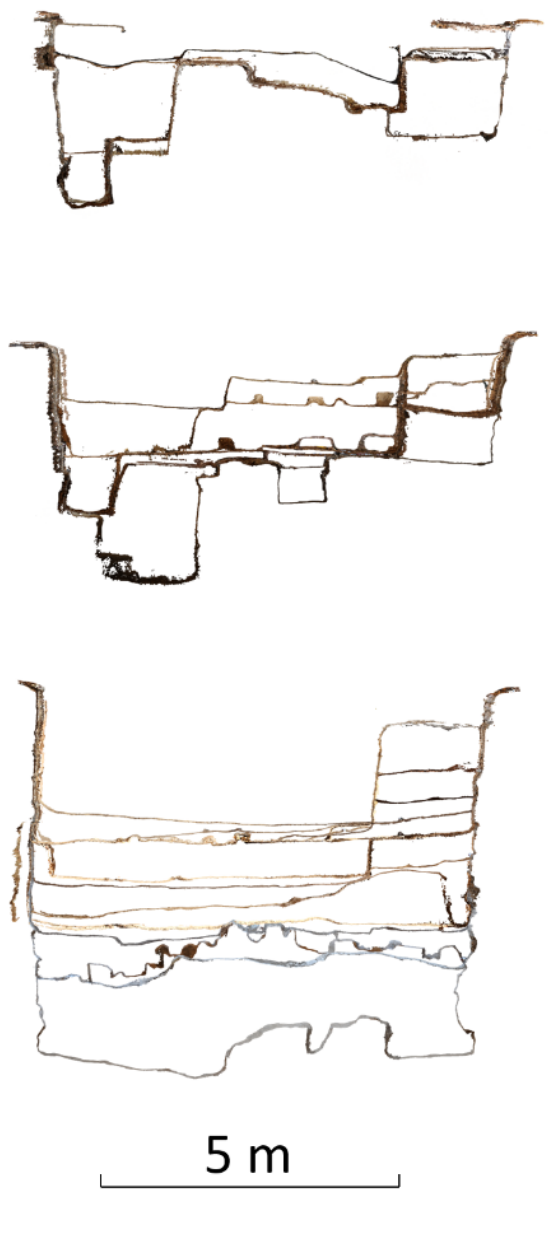
Figure 4. Three cross sections in the overlaid clouds of the excavation